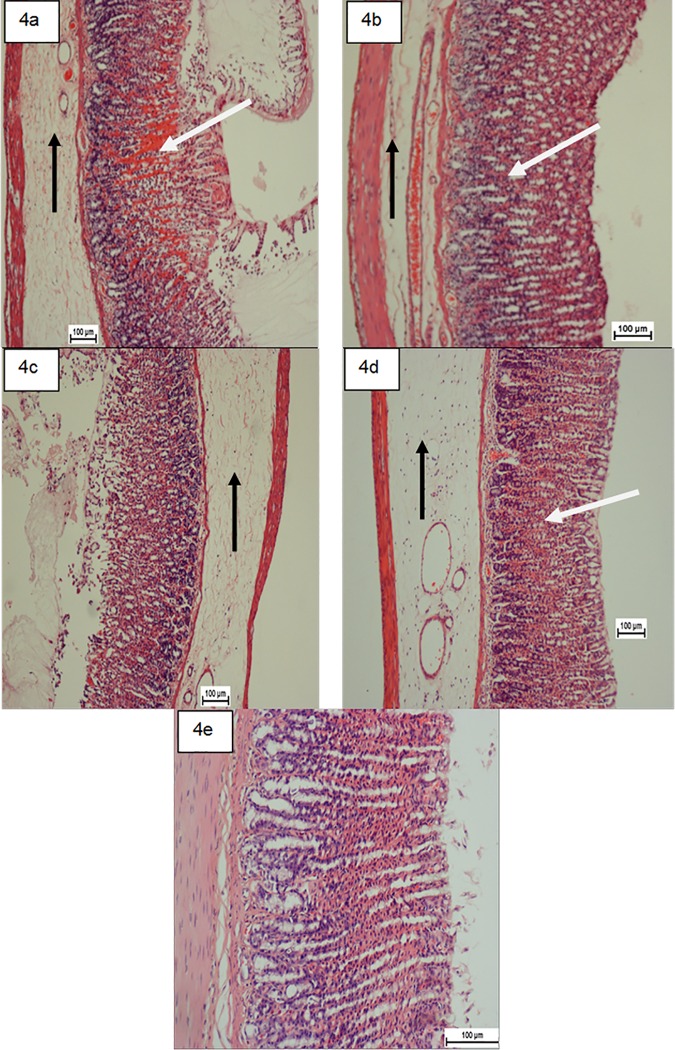
Photomicrographs showing the histological study of the absolute ethanol-induced gastric mucosal damage in rats.(4a) Rats pre-treated with 5 ml/kg of 10% Tween 20 (ulcer control). There is severe disruption to the surface epithelium and necrotic lesions penetrate deeply into mucosa (white arrow) and extensive edema of submucosa layer and leucocyte infiltration are present (black arrow). (4b) Rats pre-treated with omeprazole (20 mg/kg). Mild disruption of the surface epithelium mucosa is present (white arrow) but deep mucosal damage is absent. Reduction of submucosal edema and leucocytes infiltration (black arrow). (4c) Rat pre-treated with compound 1(50 mg/kg), mild disruption of surface epithelium are present but deep mucosal damage is absent. Reduction of submucosal edema and leucocytes infiltration (black arrow). (4d) Rat pre-treated with compound 1 (100 mg/kg), mild disruption of surface epithelium is present but deep mucosal damage is absent. Reduction of submucosal edema and leucocytes infiltration (black arrow). (4e) Rats in the normal control group showed intact gastric mucosa.